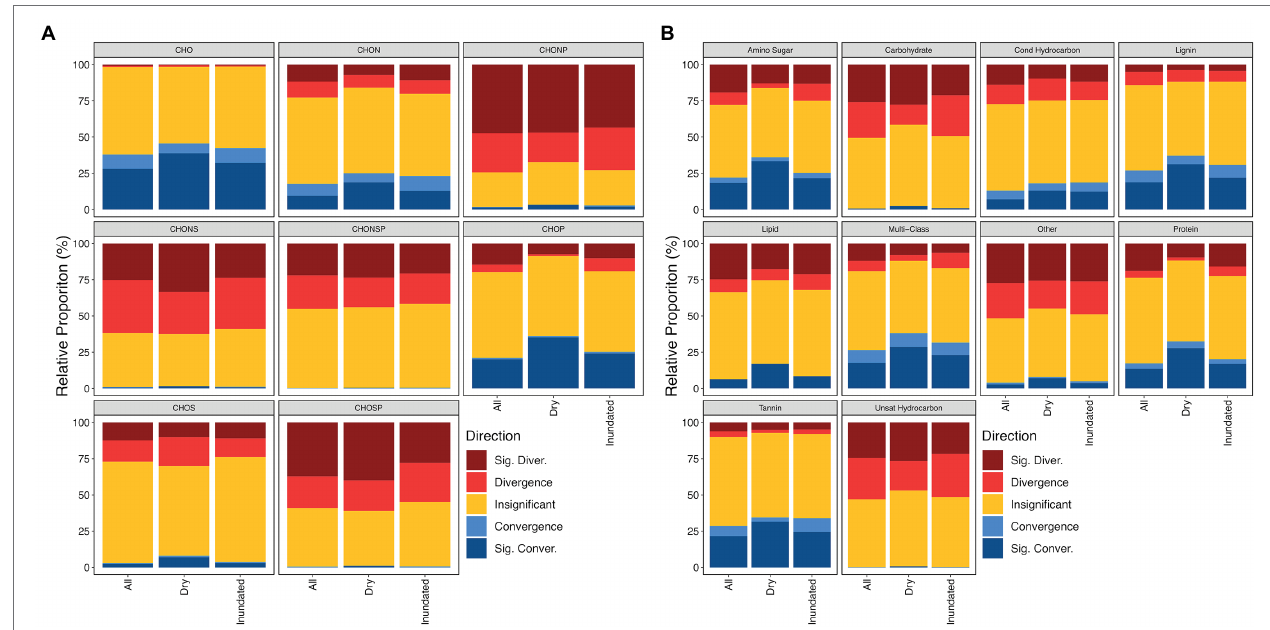
FIGURE 5 | Proportion of contributions across different elemental composition groups (A) and compound classes (B) . These graphs outline the frequency that we observe a given contribution type within a given grouping. For example, out of all CHO molecular formulas within dry assemblages, we see that they contribute to convergence more frequently than CHONSP molecular